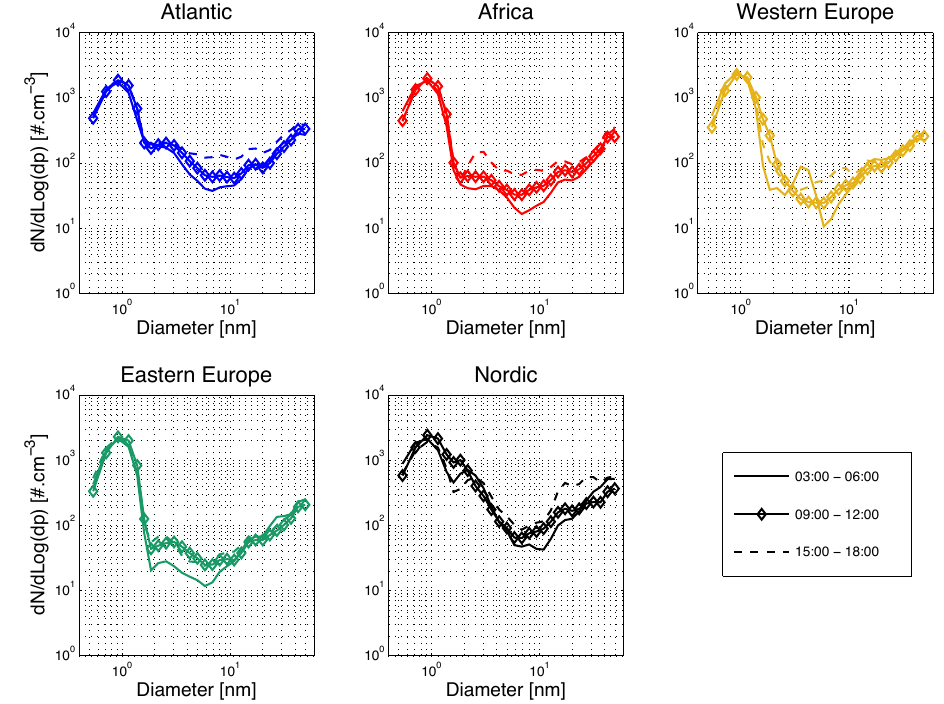
Fig. 7a. Positively charged aerosol distribution of different types of air mass origin endings at Jungfraujoch at 00:00 LT for non event days.